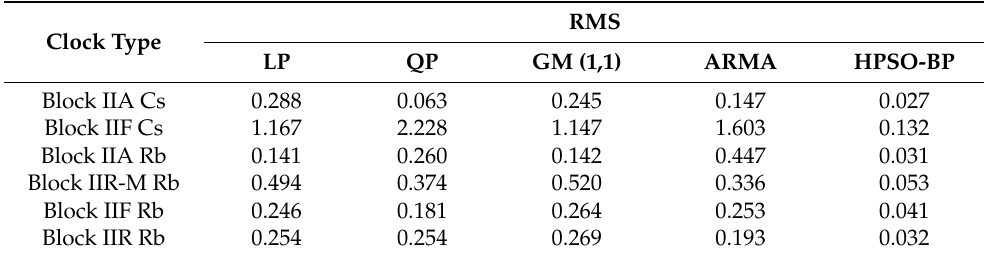
Figure 3. Prediction precision bar chart for six types of satellite clocks in 20 min for 24 March 2021.